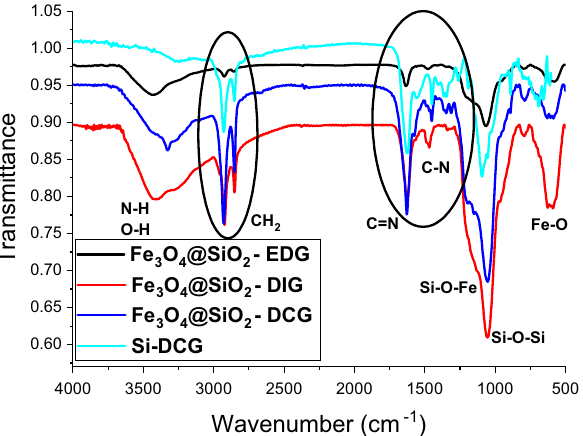
Figure 1. FTIR spectra for the magnetic catalysts (Fe 3 O 4 @SiO 2 -DCG, Fe 3 O 4 @SiO 2 -DIG, and Fe 3 O 4 @SiO 2 - EDG).